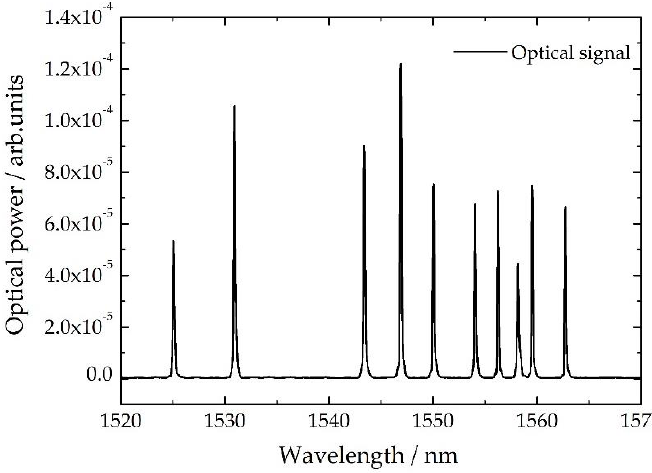
Figure 1. Spectra of the 10 fiber Bragg grating (FBG) sensors network recorded in one fiber.